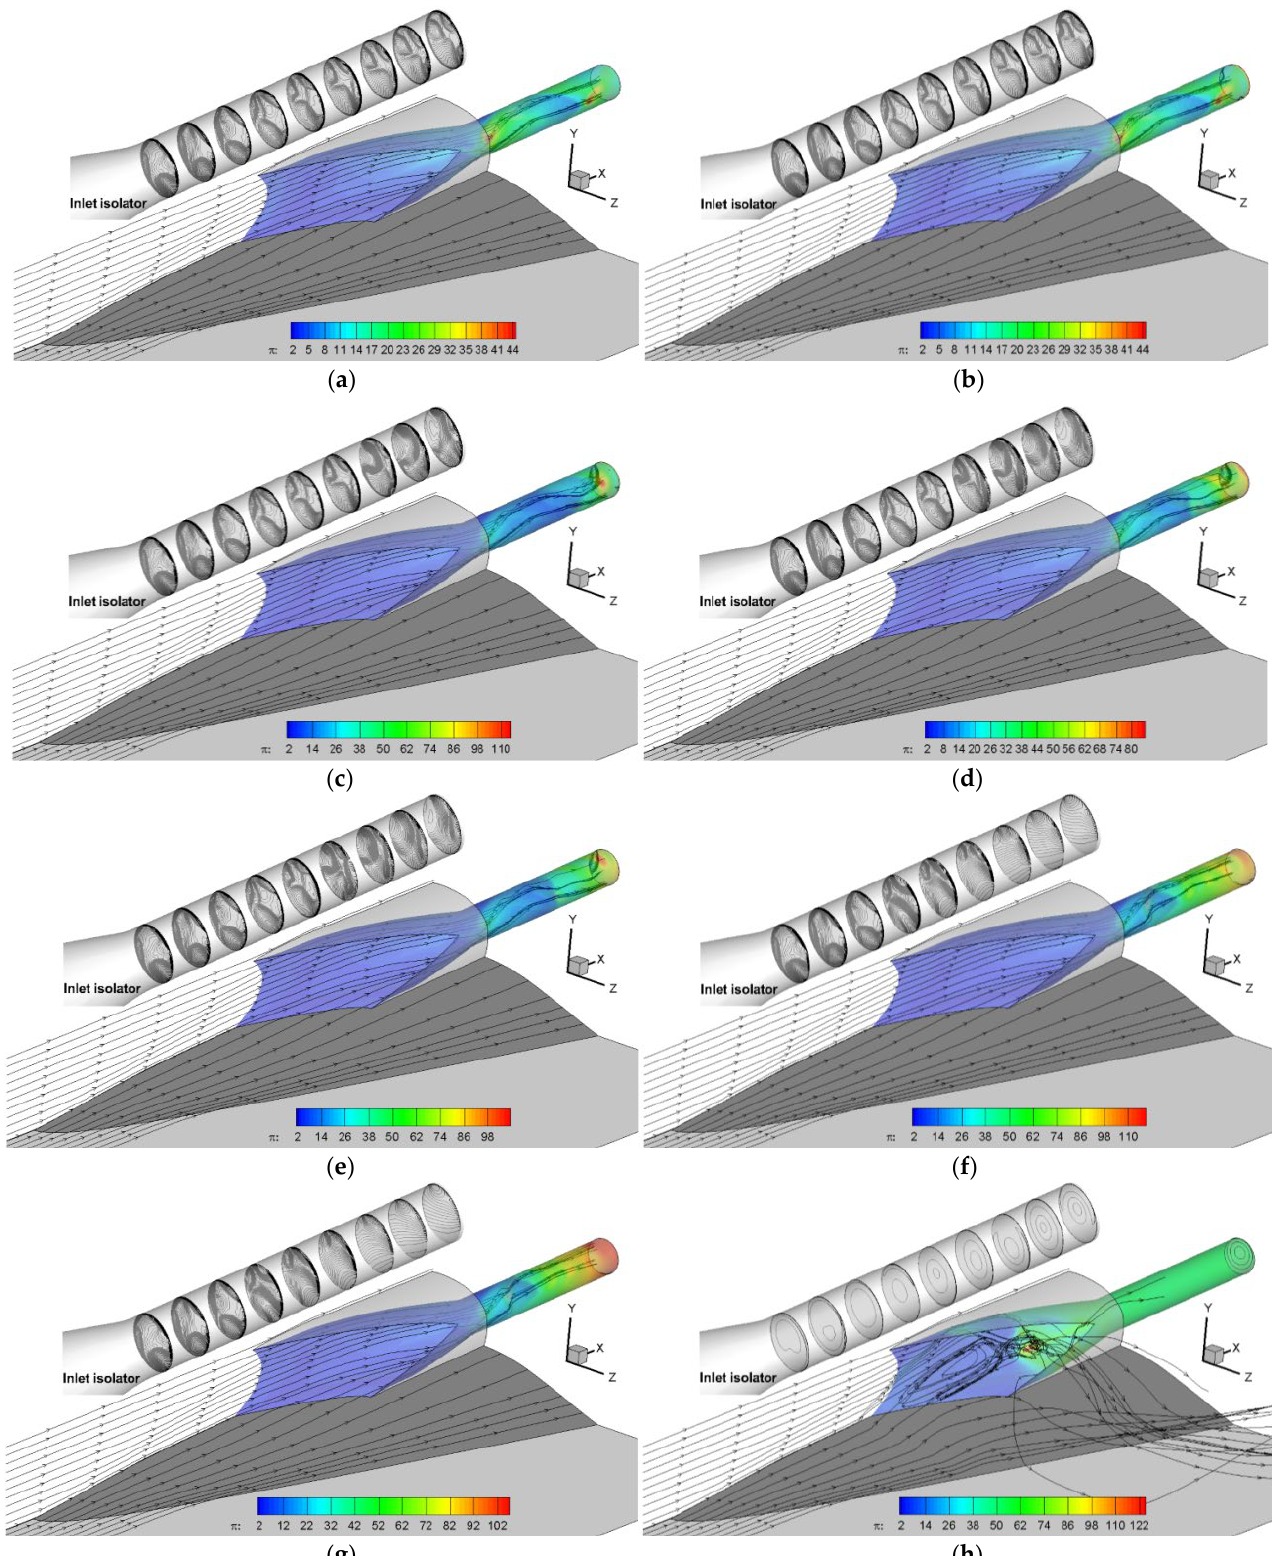
Figure 7. Pressure contours of the side-spillage integrated form ( π b = 85.6~110.0, Form 2). The speed distribution of Form 2 was studied under different backpressure condi- tions. As demonstrated in Figure 8, a series of streamlines of the near-wall region and the symmetry were obtained. The M distribution for nine longitudinal cross-sections was obtained.